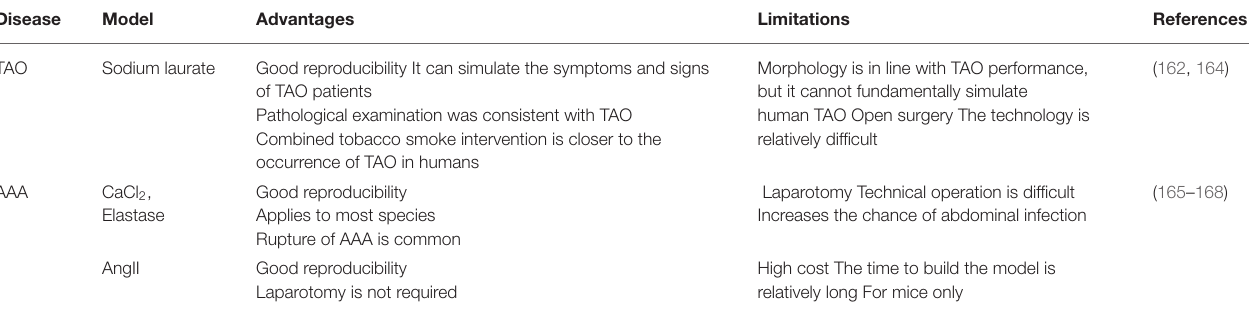
TABLE 3 | Advantages and limitations of animal models of TAO and